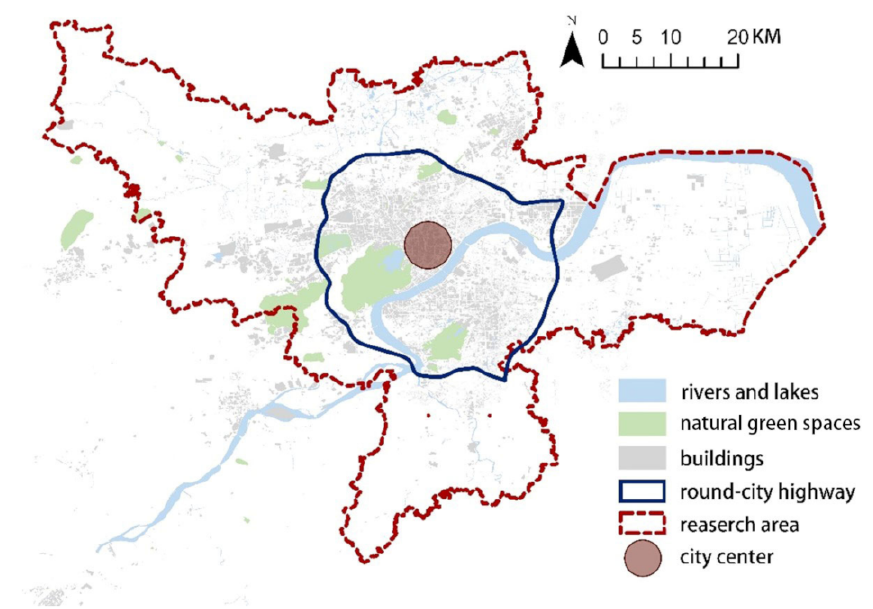
Figure 3. The research